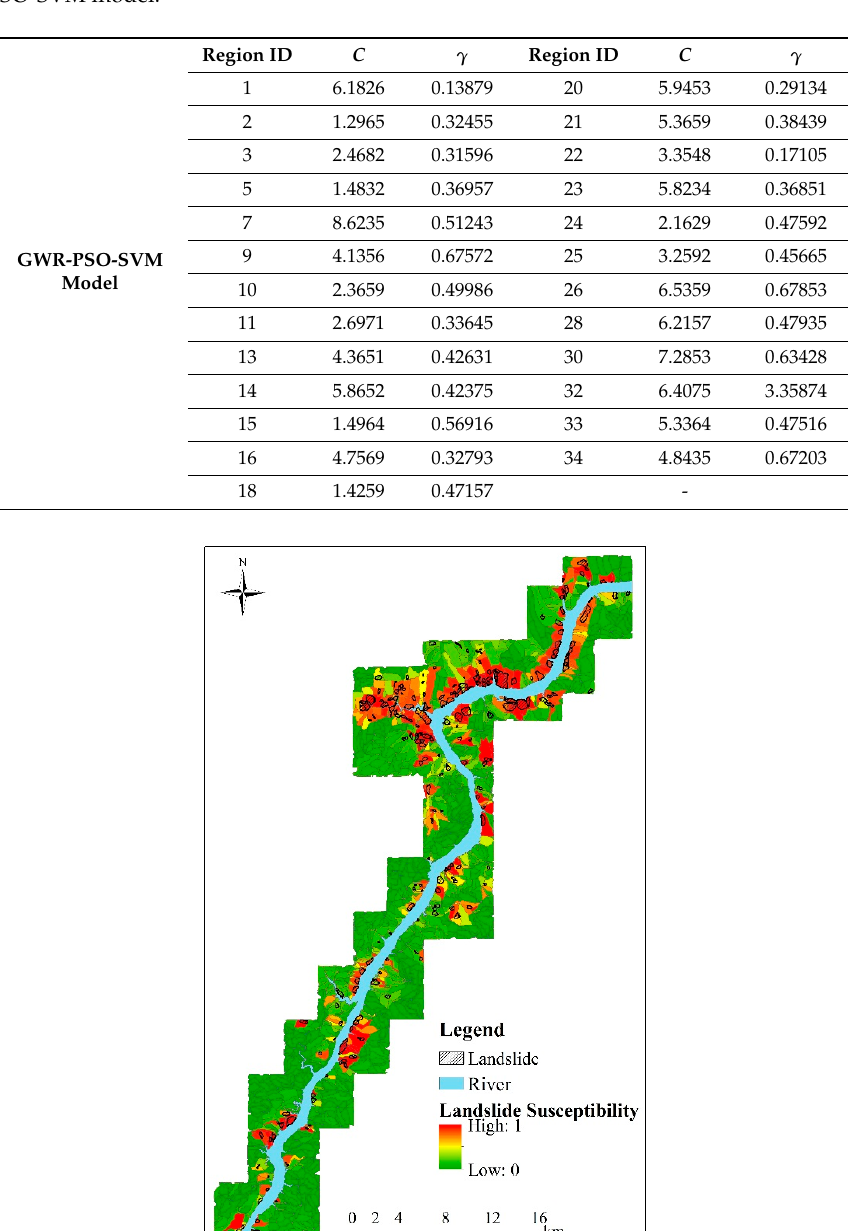
γ calculated by the PSO algorithm for the